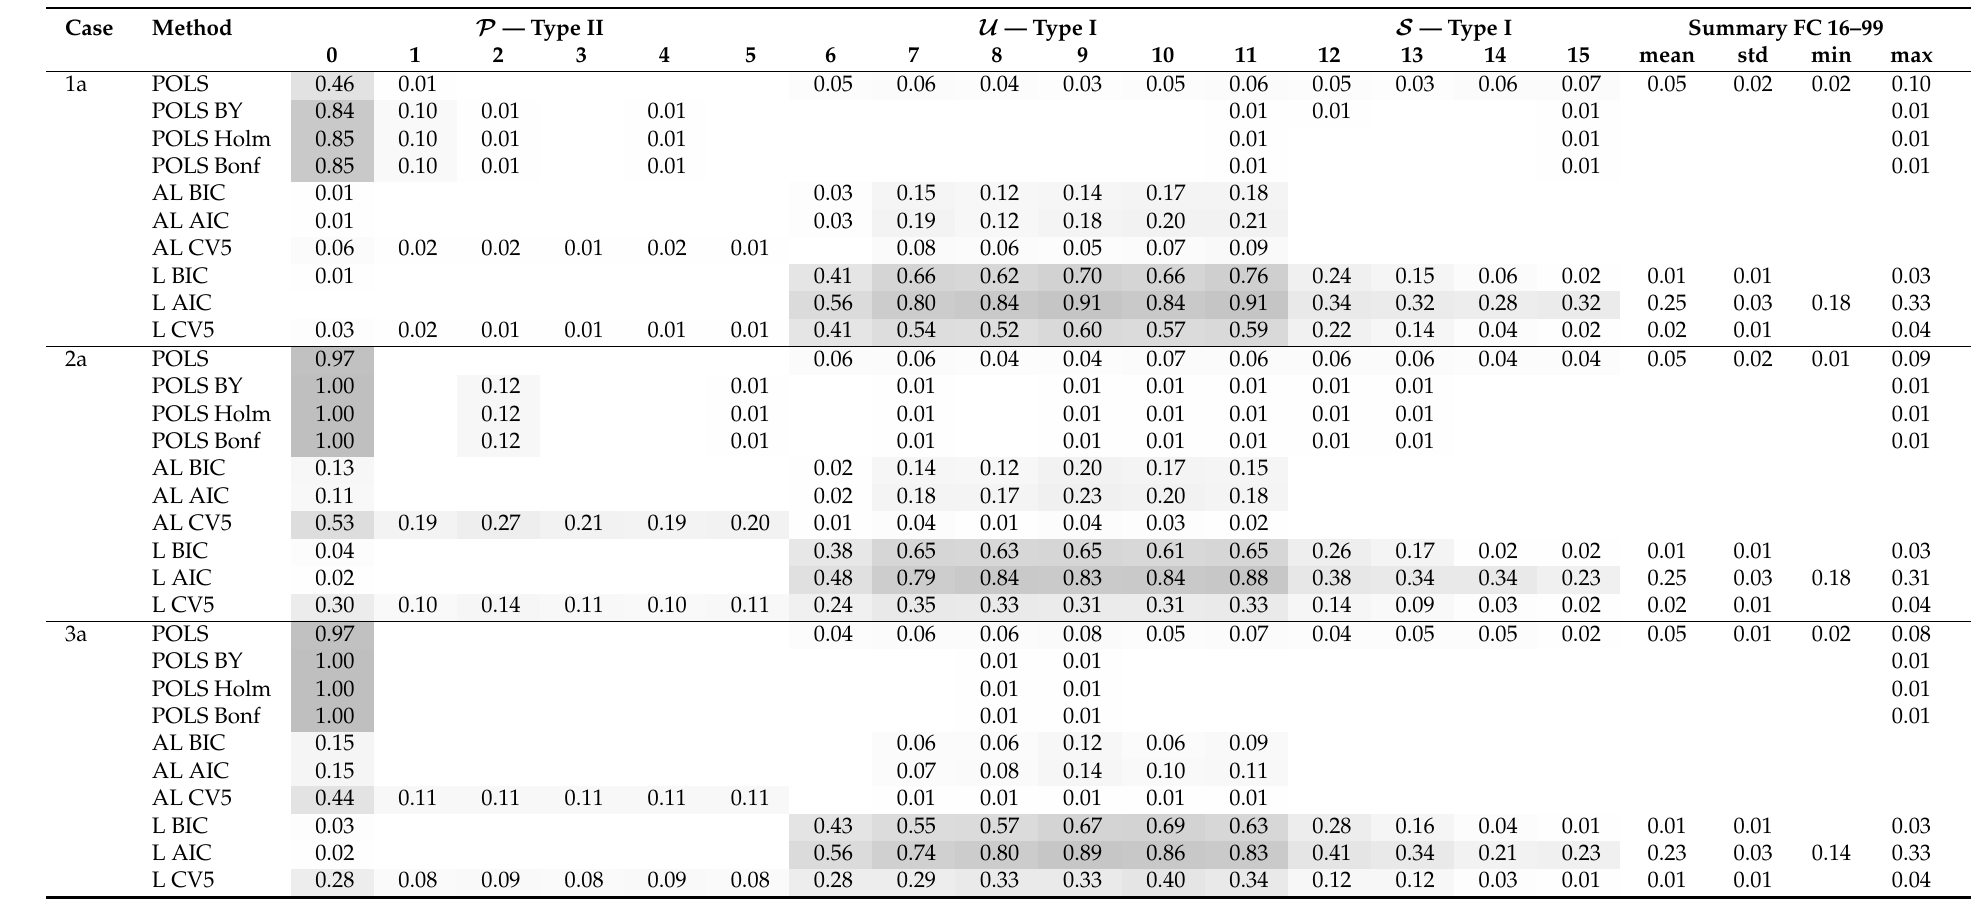
Table A1. Simulation Results: The table provides an overview of type II (for priced factor FC, FC 0–5) and type I error (for unpriced factor FC, 6–11, and spurious FC, 12–99) ratio behavior in percentage points for the specified simulation cases. All details of the cases can be found in Appendix A.2.1. FC cases 12–15 are interesting insofar as they are spurious FC with high correlations to priced and unpriced FC. A white space represents a zero value. Please note that the results displayed are based on 200 simulations